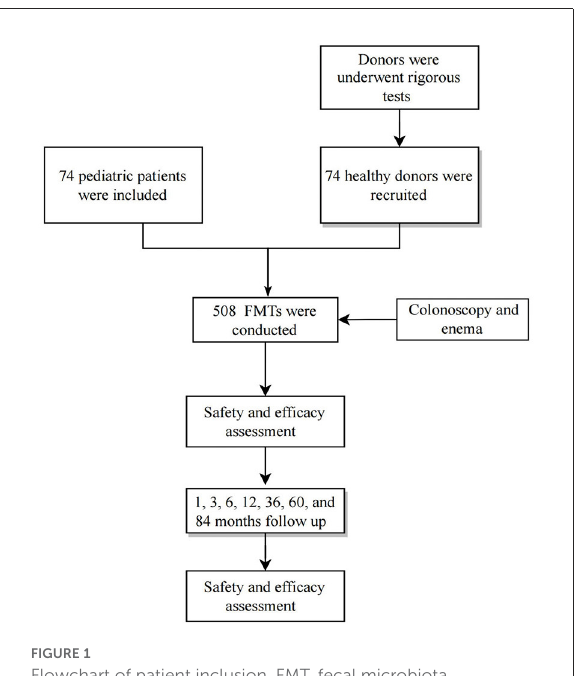
FIGURE1 Flowchart of patient inclusion. FMT, fecal microbiota